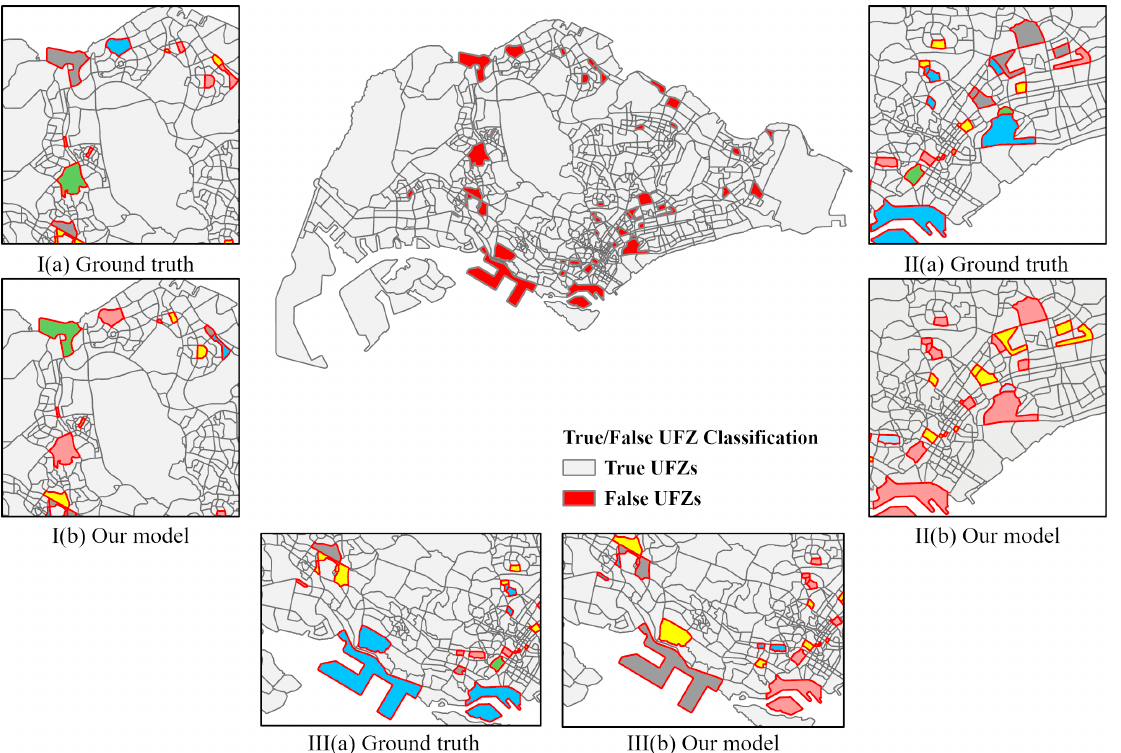
Figure 10. Misclassification map in Singapore using Graph SAGE model.